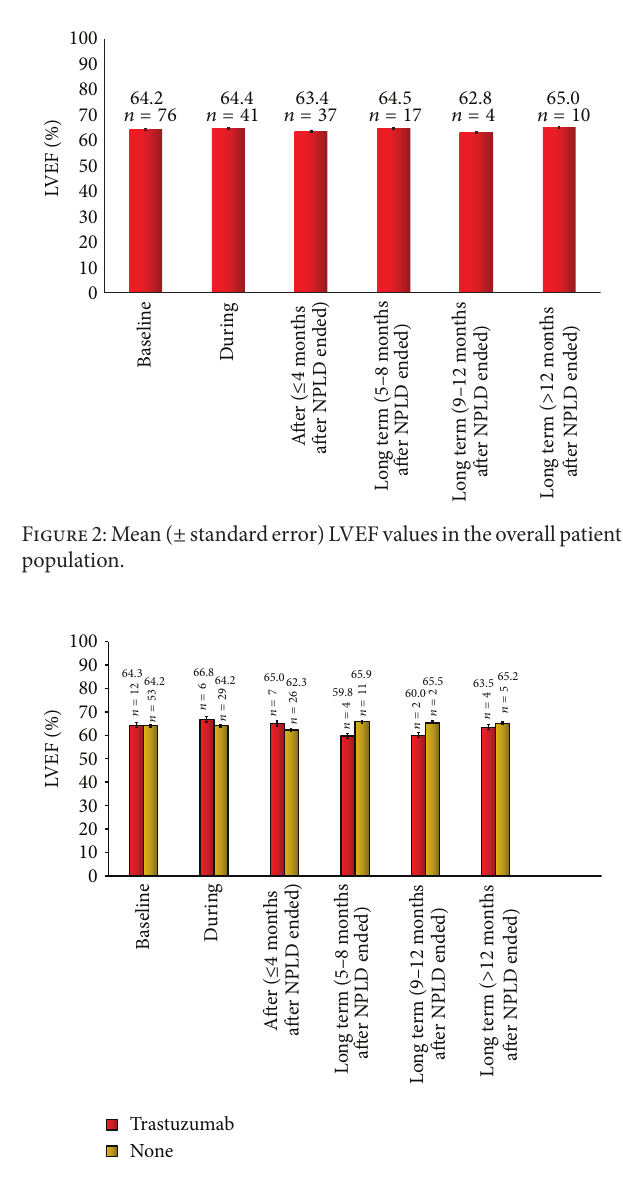
Figure 3: Mean ( ± standard error) LVEF values in patients who did or did not receive